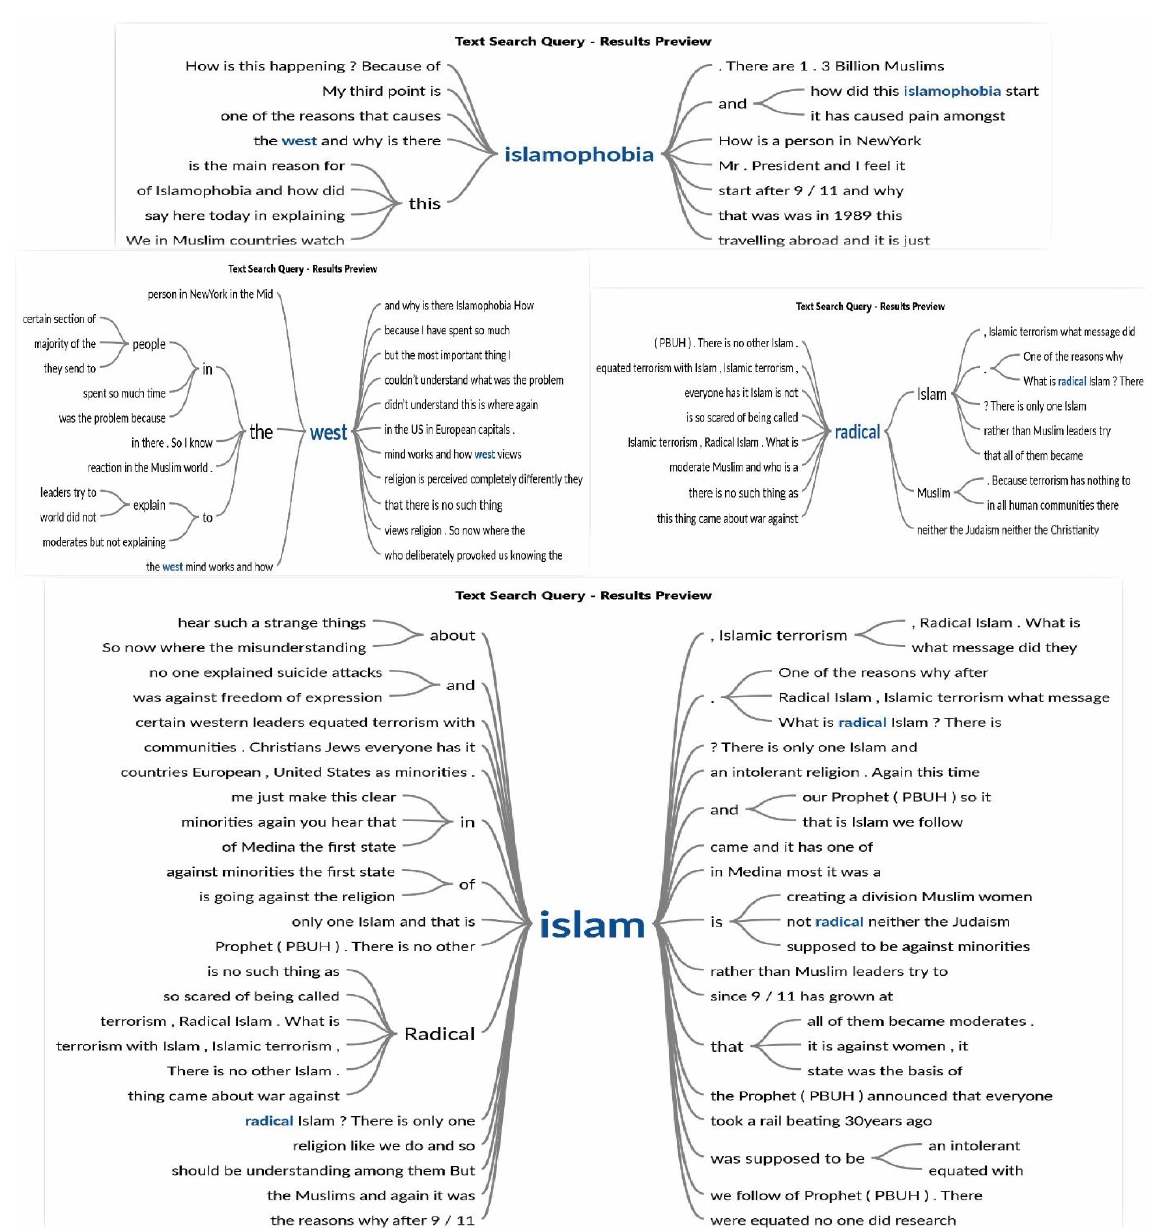
Figure 5. Word trees of frequently used terms in the Imran Khan’s